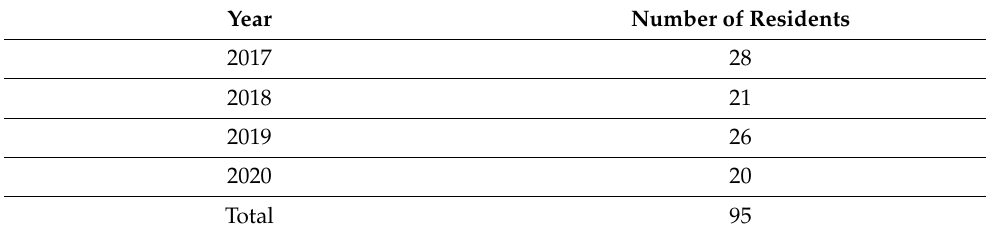
Table 3. An overview of the number of interviews with